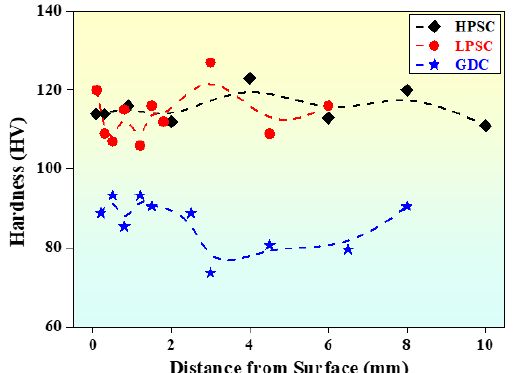
Figure 3. Microhardness survey taken for the cast samples in all three conditions (gravity die casting (GDC), low-pressure squeeze-casting (LPSC), and high-pressure squeeze-casting (HPSC) taken from surface to center of the casting).